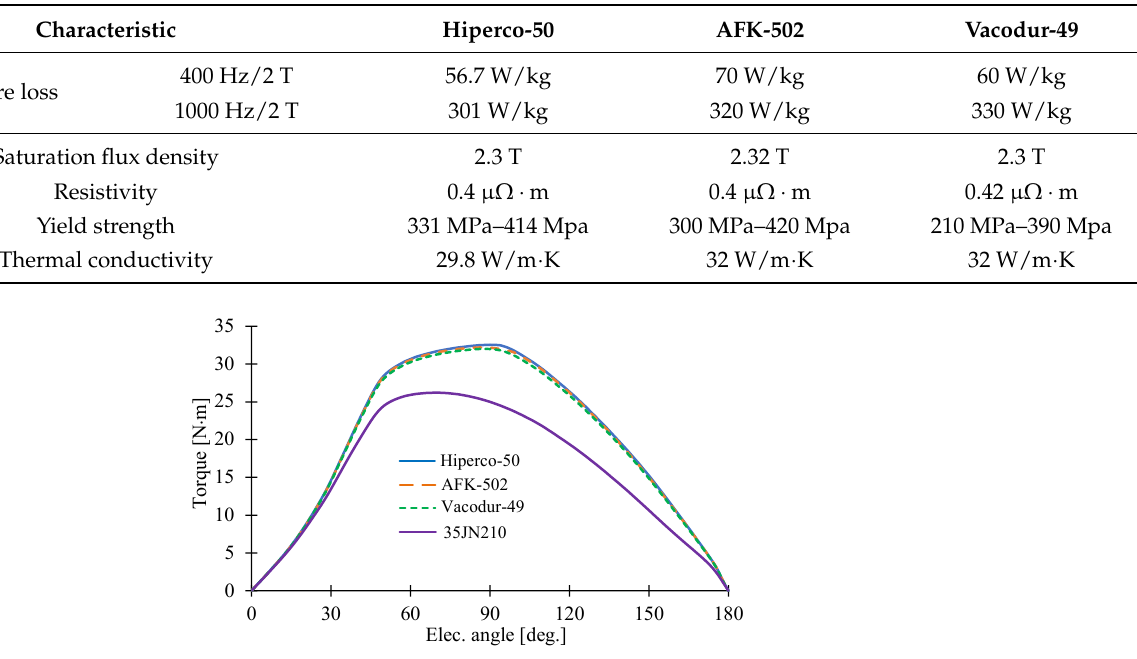
Figure 10. Static torque profiles at a 60 A excitation current for different magnetic materials.